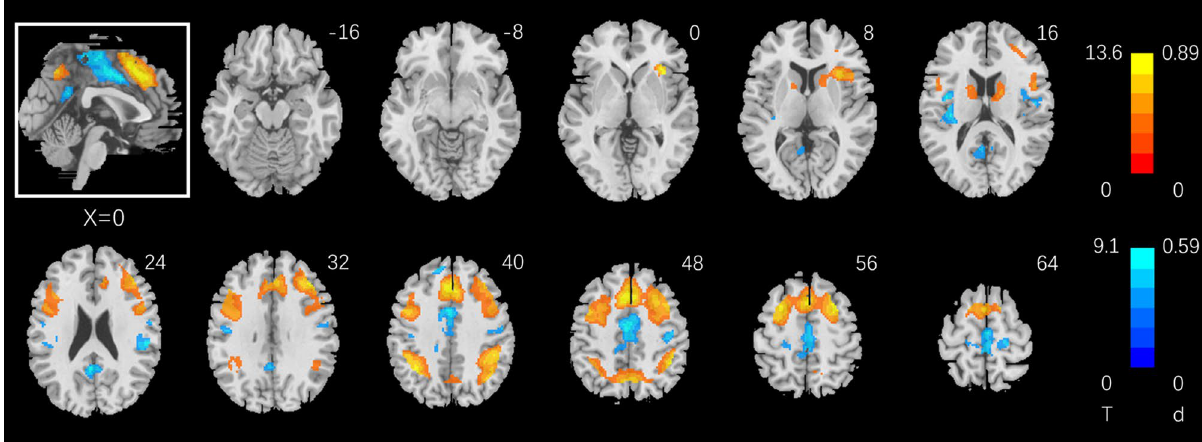
Figure 4. Whole-brain multiple regression against RT 2–0 (correct trials only) with age, sex, and years of education as covariates. Voxel p < 0.05, FWE corrected. Voxels in warm/cool colors show positive/negative correlations. Color bars show voxel T values and the corresponding Cohen’s d scores. The inset shows a mid- sagittal section of the clusters.